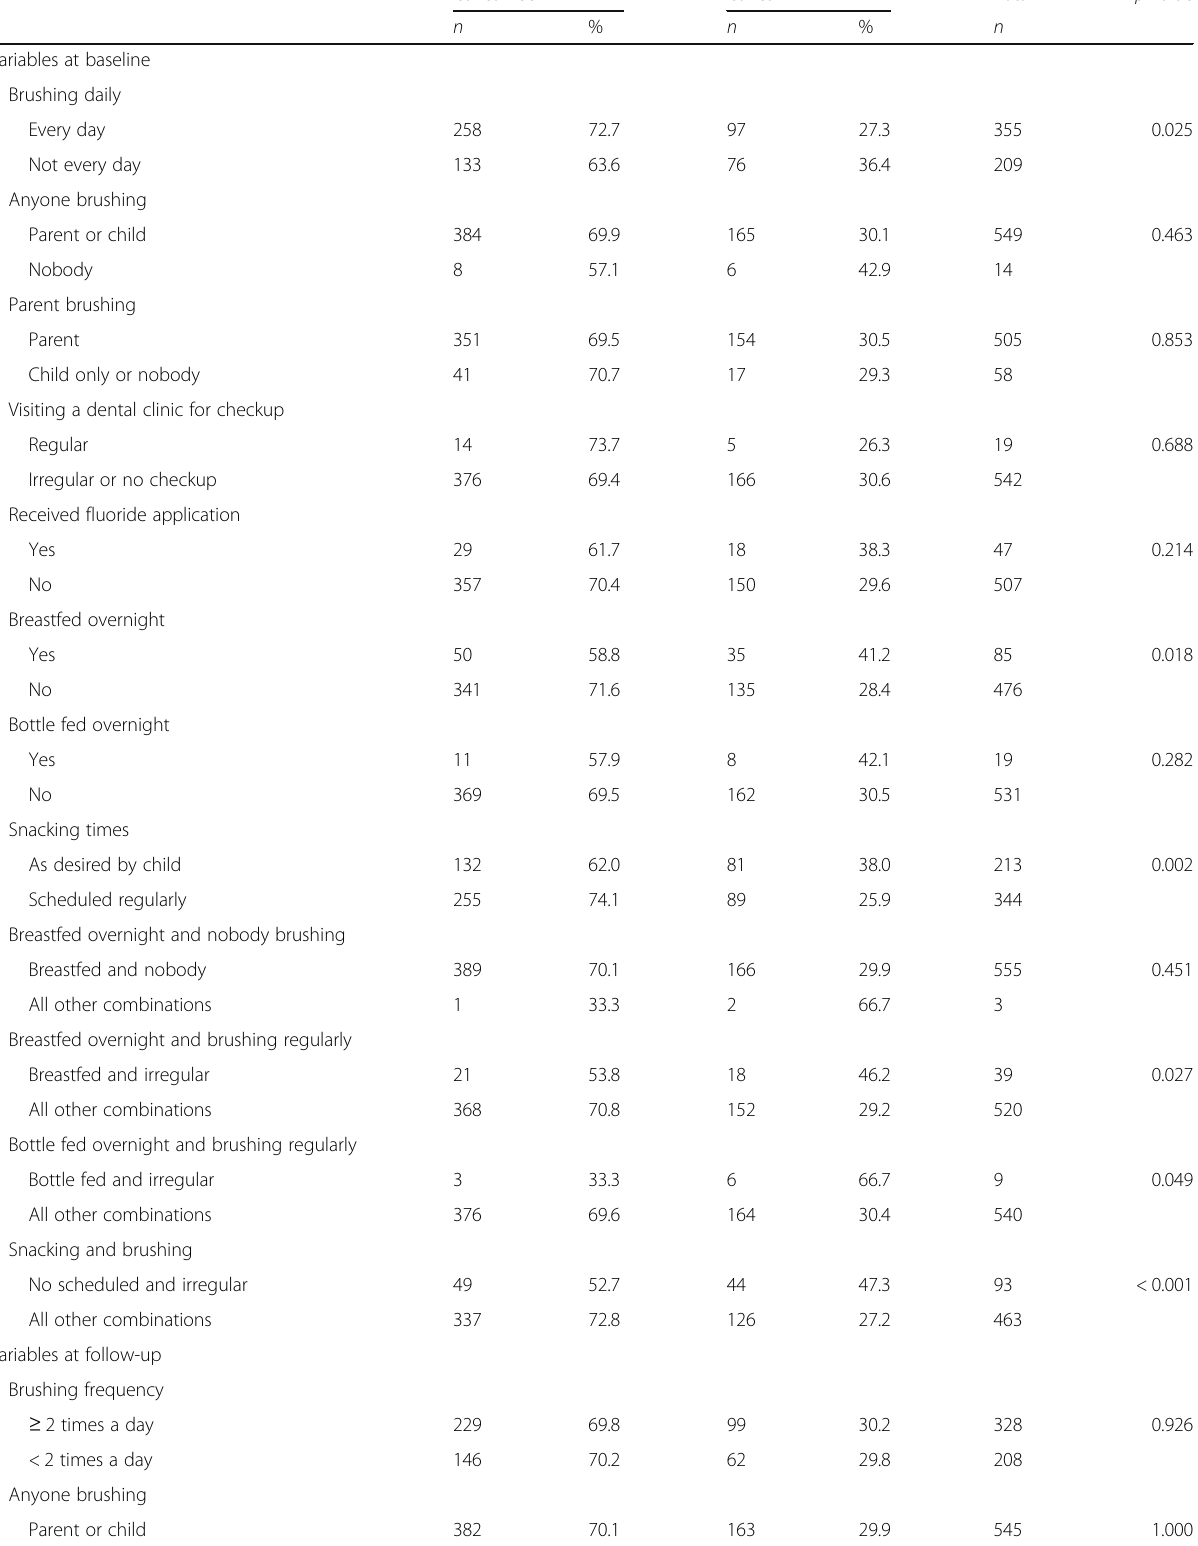
Table 4 Health habits associated with caries at follow-up ( n = 556) Caries-free Caries